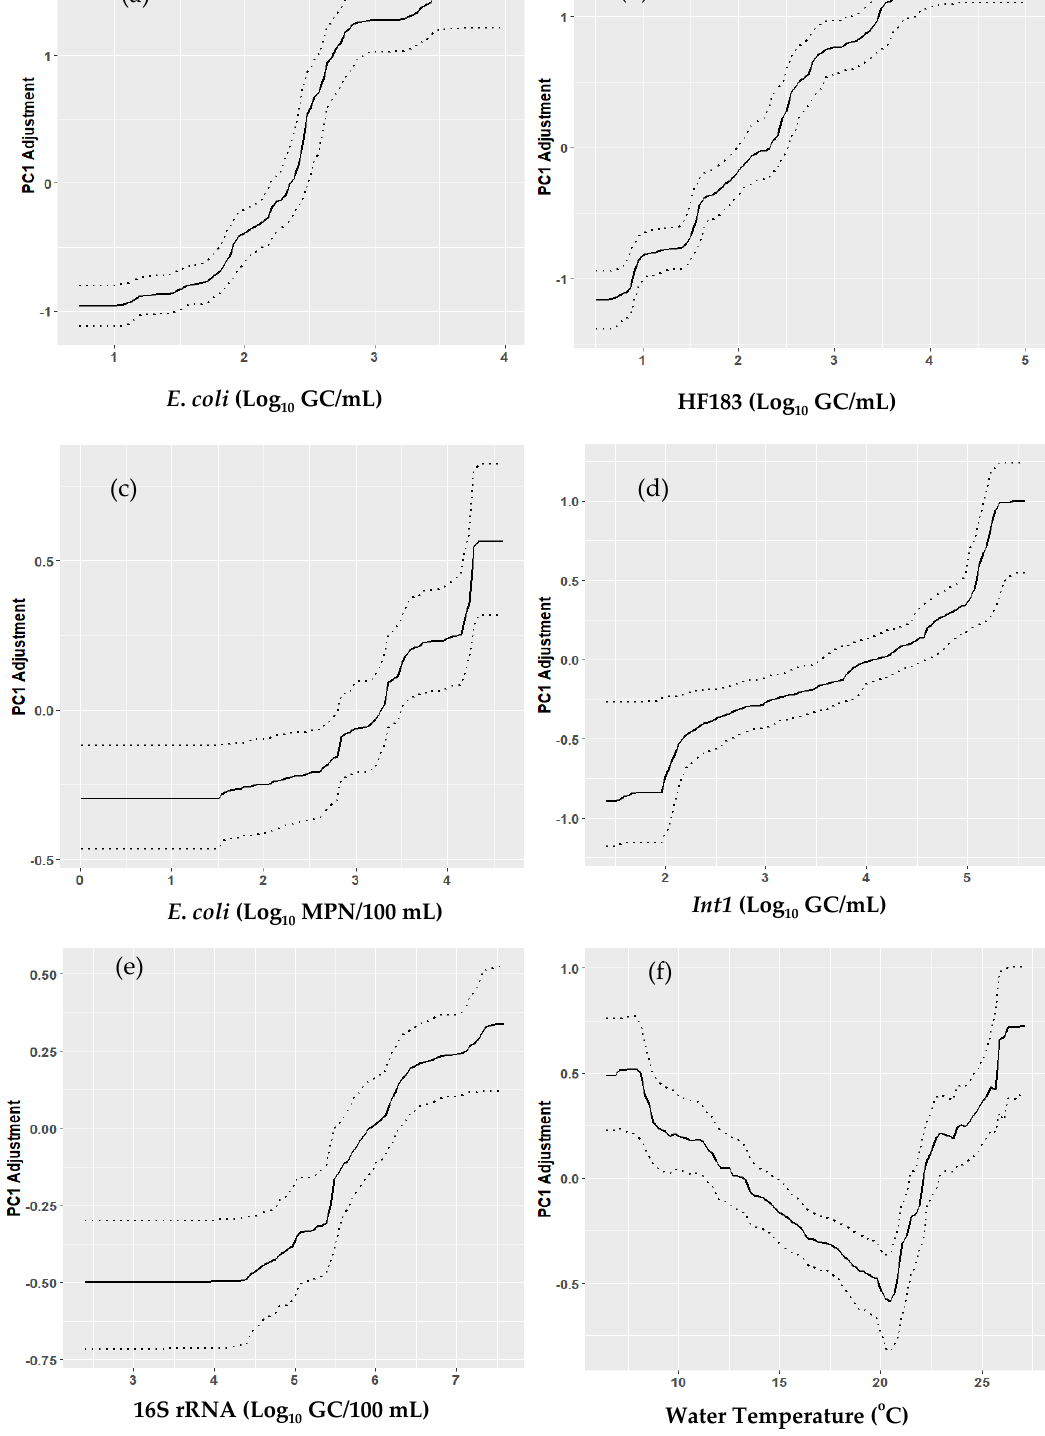
Figure 5. Partial dependence plots showing the response of PC1 scores to changes in predictor variables E. coli marker ( a ), HF183 ( b ), culturable E. coli ( c ), int 1 ( d ), 16S ( e ) and water temperature ( f ) in the Refined PC1 model. Dotted line shows the 95% confidence band based on 500 runs of the Refined PC1 model.